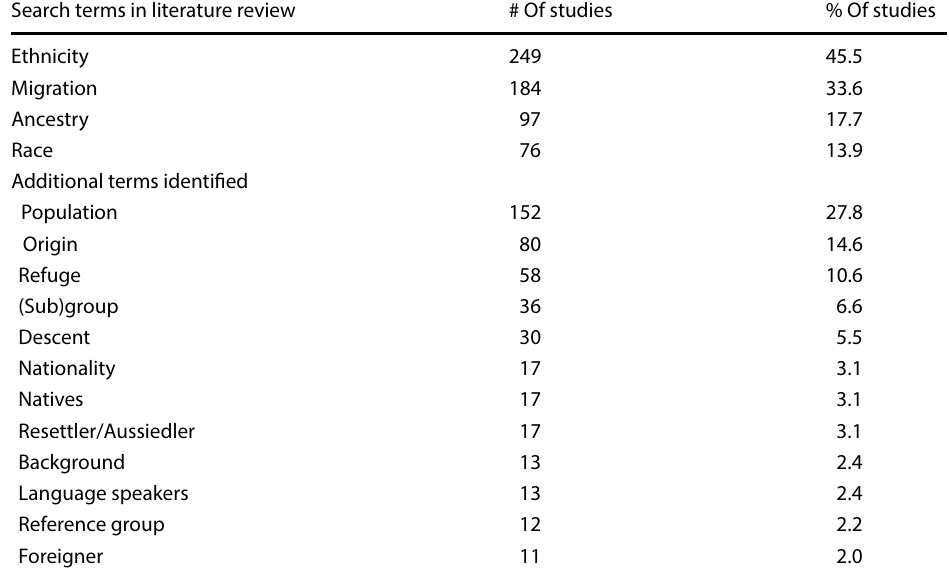
Table 1 Human classifications used in life science studies from